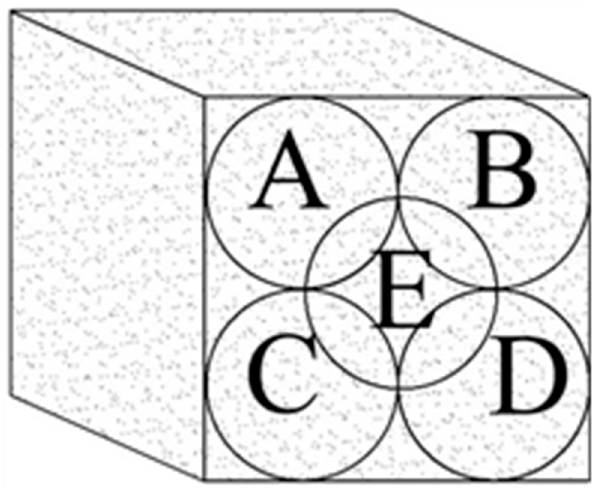
Figure 3. Pundit testing tool.